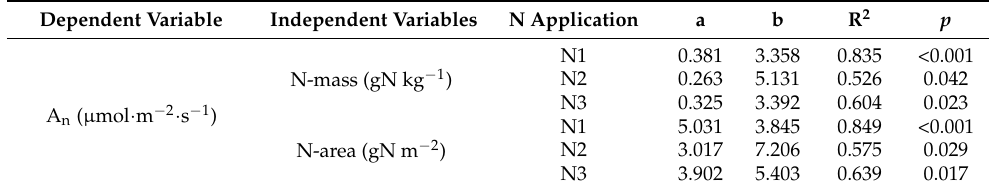
Figure 8. Correlations between the photosynthetic rate (A n ) and N-mass and N-area. ( a , b ) represent the correlation between A n and N-mass as well as between A n and N-area under different measure- ment dates, respectively. ( c , d ) represent the relationships between A n and N-mass as well as between A n and N-area under different N applications. The arrows in the figure correspond to the regression lines under different N treatments. Table 3. Parameters of linear regression and accuracy evaluation of the fitting equation between A n and N-mass and N-area.